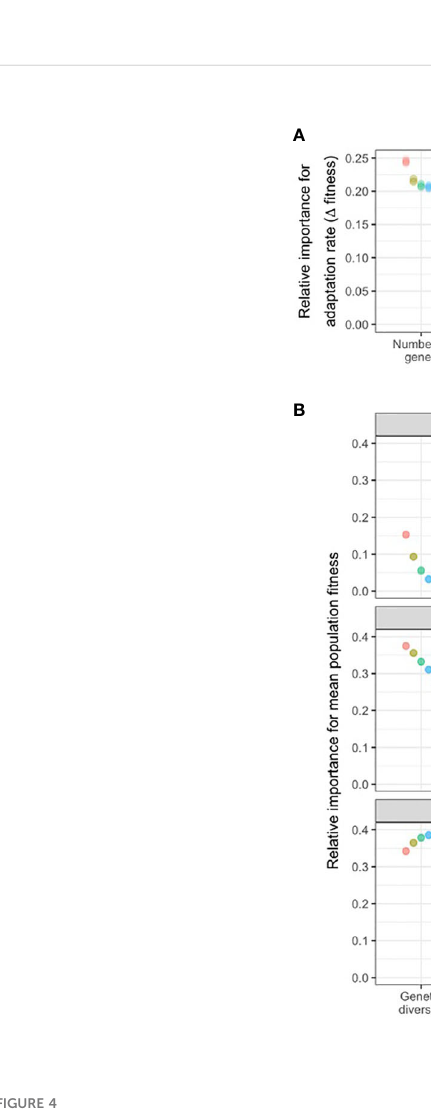
FIGURE 4 The relative importance of population genomic parameters for the (A) rate of adaptation (change in fi tness in the fi rst 20 generations of warming; and (B) mean population fi tness after 20, 50 and 100 generations of warming. Relative importance of model parameters for the rate of adaptation was measured by the standard deviation (sd) of the fi tness differences at the start of a 0.01°C/generation warming and 20 generations later, varying the target parameter while keeping the others constant. Relative importance of model parameters on mean population fi tness was measured by the sd of the fi tness values at 20, 50 and 100 generations of 0.01°C/generation warming, varying the target parameter while keeping the others constant. Populations were distributed along an environmental gradient with decreasing temperature from Population 1 to 5, and with twice as much migration from warm to cold populations than from cold to warm populations. Results for ten independent simulations are presented for each permutation of parameters as raw data (due to low within-group variability) and overlayed as points with